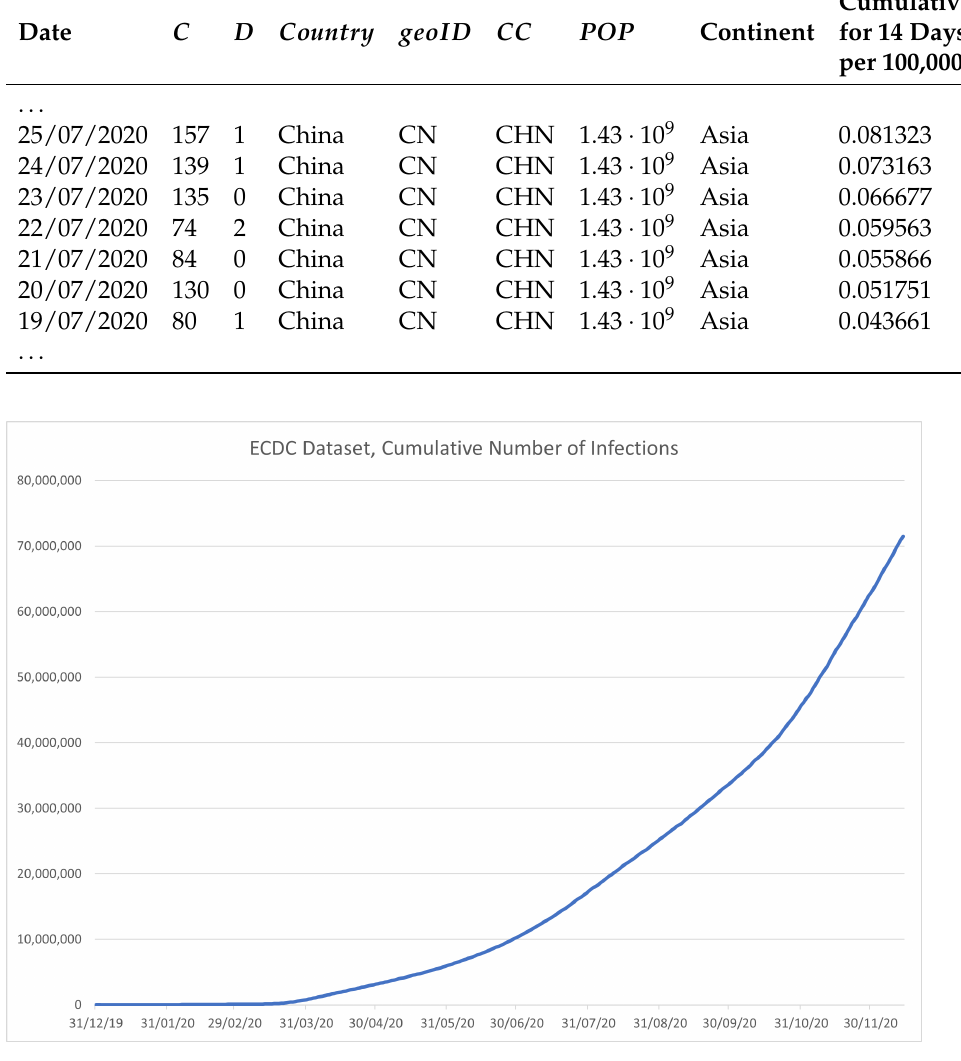
Figure 7. Time-series plot of the data in the ECDC dataset, for confirmed patients, contained within the